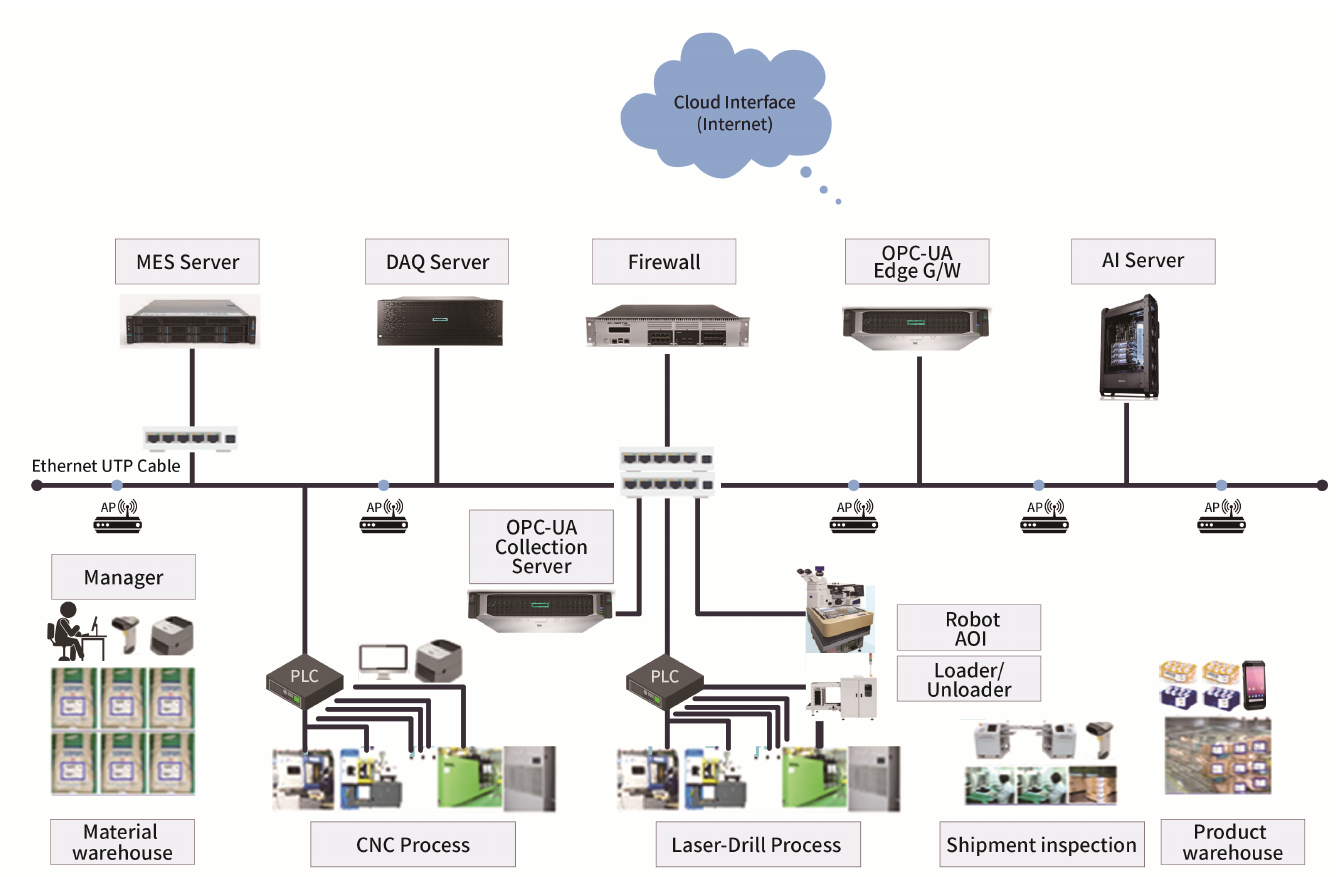
Figure 9. The hardware